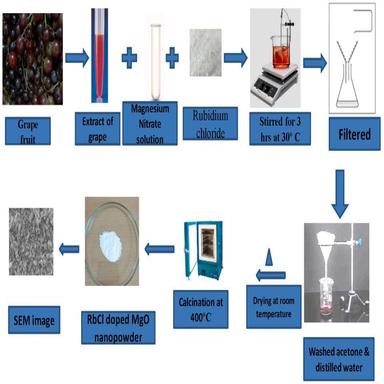
Schematic diagramatic representation for the synthesis of rubidium chloride doped magnesium oxide nanomaterial.